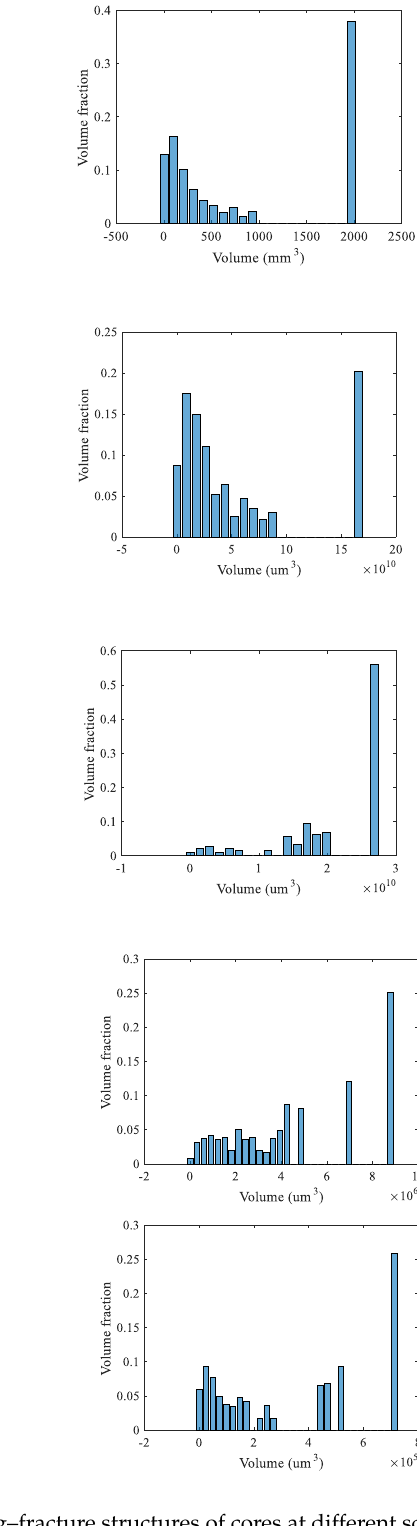
Figure 6. Distribution characteristics of pore – vug – fracture structures of cores at different scales. Carbonate reservoirs develop different degrees of pores, vugs, and fractures, which can be categorized as triple media in a broad sense. However, the storage and seepage characteristics vary widely depending on the scale and collocation relationships of pores, vugs, and fractures. Therefore, it is of strong practical value to quantify and visualize the collocation relationships of pores, vugs, and fractures on different scales. Figure 7 shows the pore – vug – fracture relationships of representative cores at different scales, with red indicating pores, blue indicating fractures, and green indicating cavities. The selected representative cores cover three reservoir types: pore, pore – vug, and pore – vug – fracture. Figure 7. Spatial distribution of pores and cavities in representative cores at different scales (red indicates pores, blue indicates fractures, green indicates cavities). Regardless of the resolution, the pore network of all cores is not connected, even if the CT resolution has reached 0.5 μ m. This indicates that the carbonate matrix is particularly dense, and the pores identified by CT are not intergranular voids produced during rock crystallization, but rather intergranular solution pores produced by dissolution. Otherwise, the pore distribution would not be so sparse and disconnected. The 45 mm and 75 mm cores belong to the pore – vug – fracture type, where the distribution of pores and cavities is relatively scattered, and the fractures are distributed in a network between pores and cavities. Pores are the main storage space, and fractures are the main flow channels. The 13 mm cores belong to the pore – vug type, and the 1 mm and 0.9 mm cores belong to the pore type. As the observed core scale increases, the Pore Fracture Vug